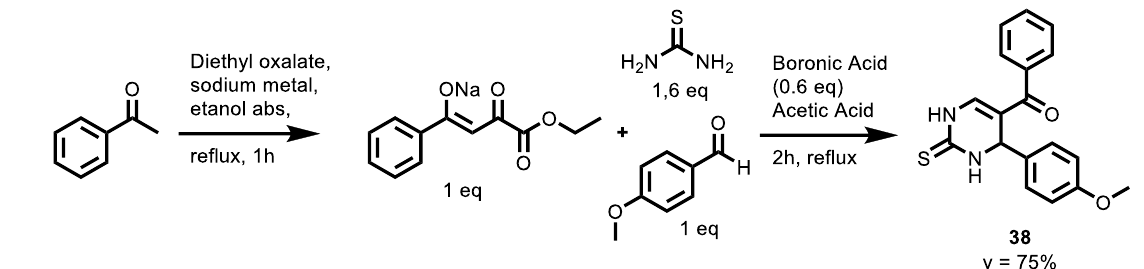
Scheme 17. Synthesis of compound 38 of new